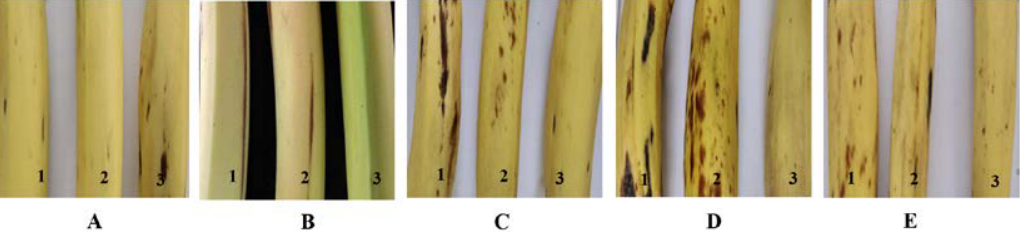
Fig. 3.2. 5 th day of banana sample treated with different treatment A. Sodium alginate B. Starch C. Aloe vera D. Gelatin E. Glycerol